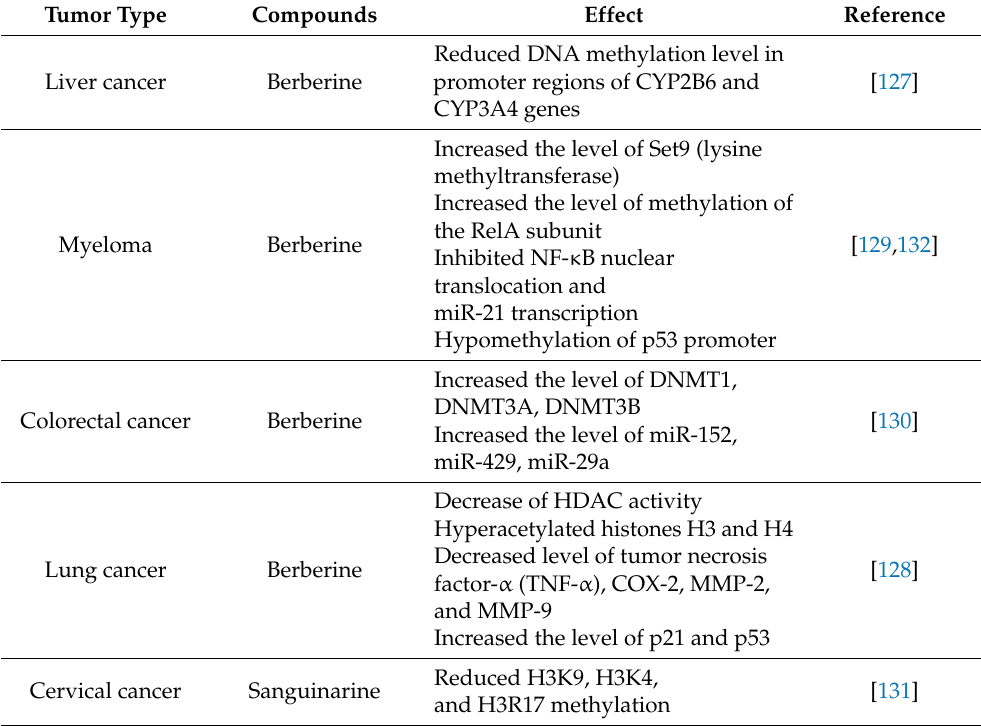
Table 2. Epigenetic modulation in isoquinoline-induced cell